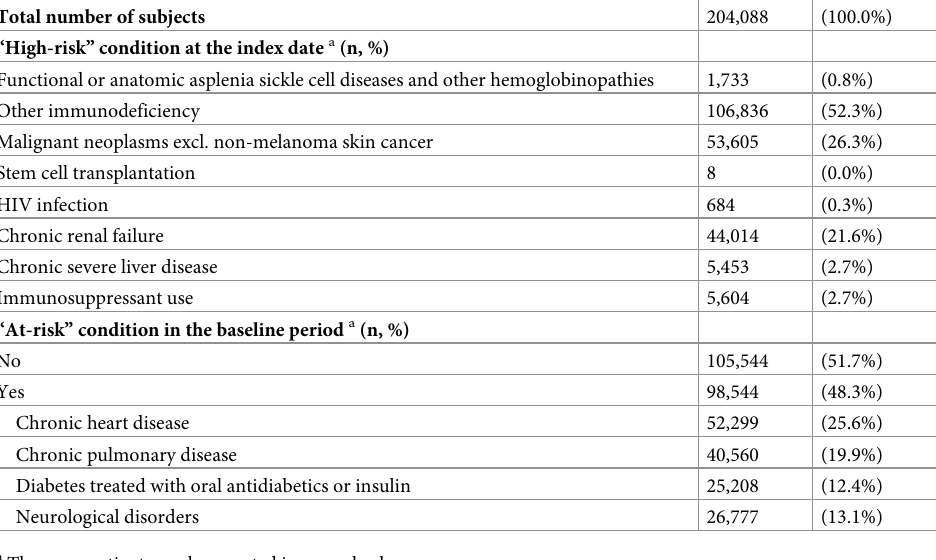
Total number of